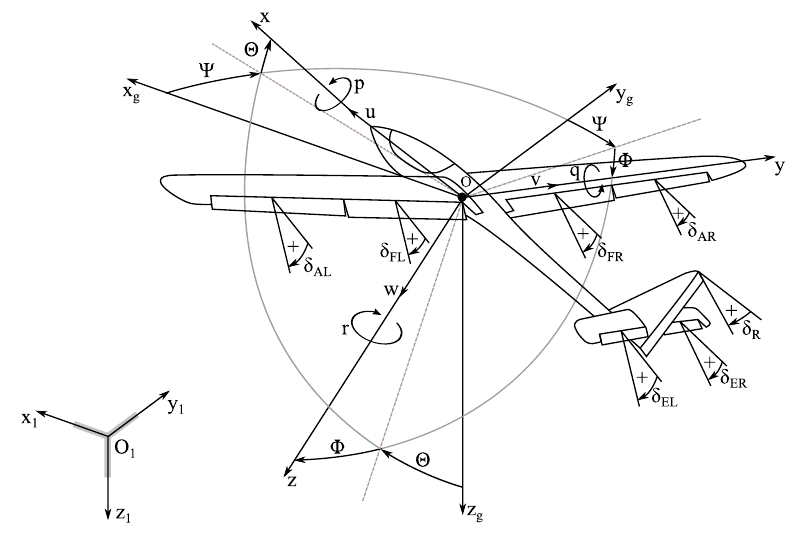
Figure 2. Coordinate system, state, and control